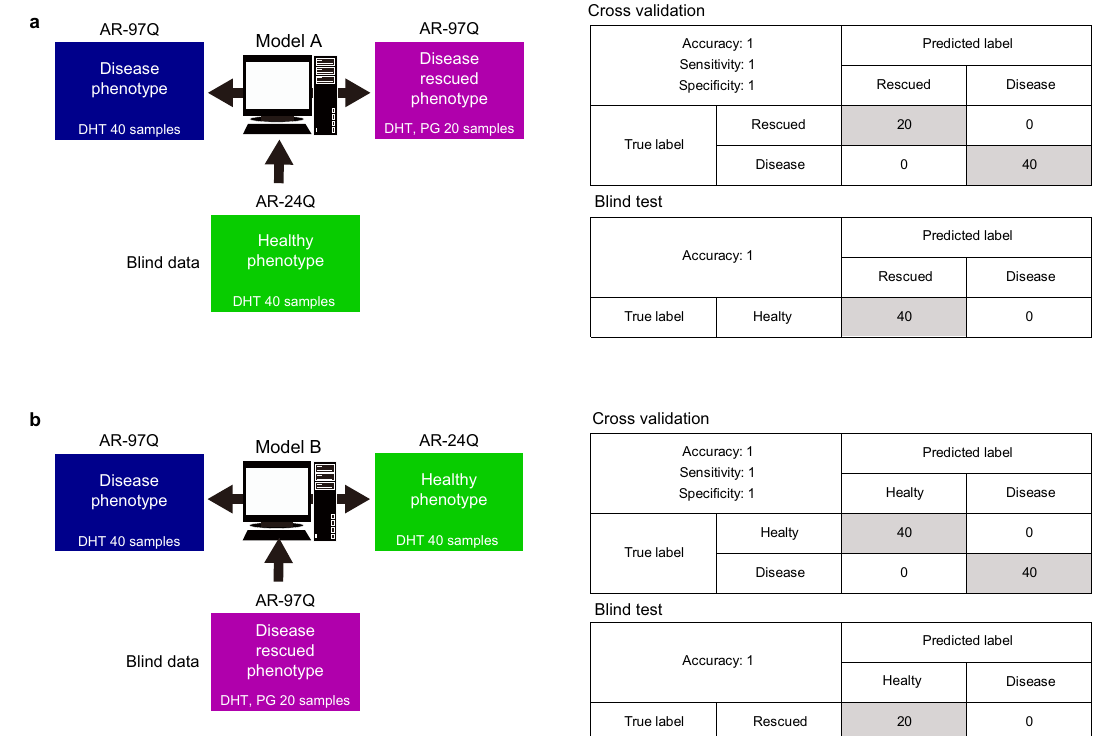
Figure 5. Concept and performances of phenotype classification trained with focused population data (pDs). ( a ) Model A is trained to classify the disease phenotype (AR-97Q cells with dihydrotestosterone (DHT)) and the rescued phenotype (AR-97Q cells treated with pioglitazone (PG) and DHT). The classification performances based on cross-validation and blind test data are shown in tables. ( b ) Model B is trained to classify the disease phenotype and healthy phenotype (AR-24Q cells with DHT). The classification performances based on cross- validation and blind test data are shown in tables. All illustrations created by Adobe Illustrator 24.1.1 (https:// www. adobe. com/ jp/ produ cts/ illus trator.